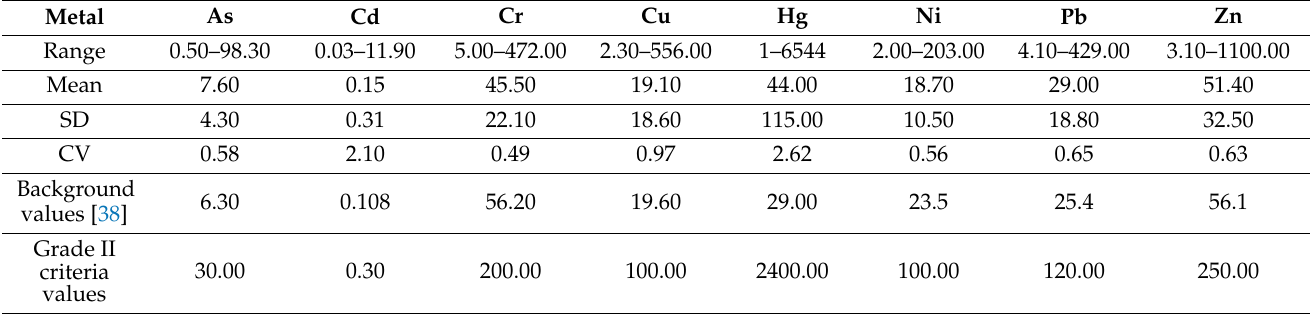
Table 6. Descriptive Statistic of Eight Heavy Metals Concentrations in Surface Soils from